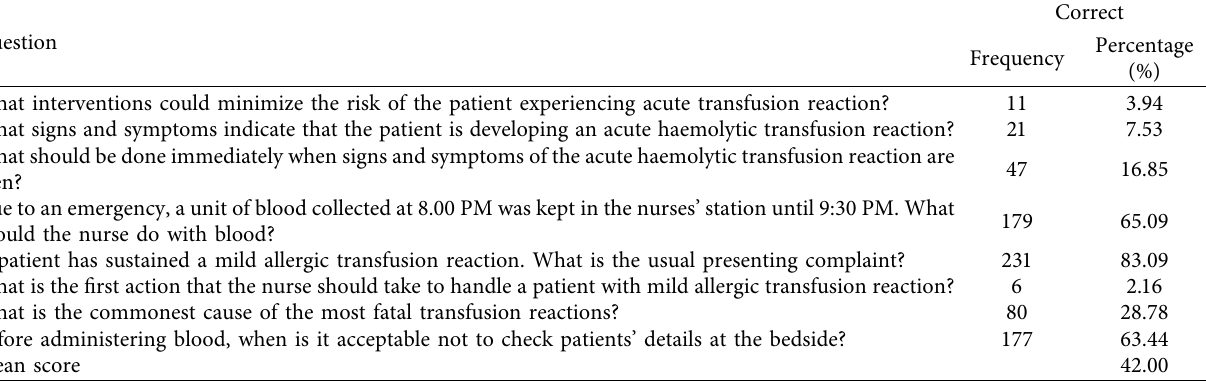
Table 9: Knowledge of nurses on blood transfusion complications.